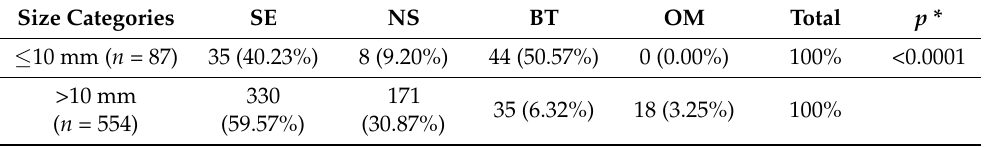
Table 4. Frequencies of histologic subgroups in tumour size categories of ≤ 10 mm and >10 mm. Size